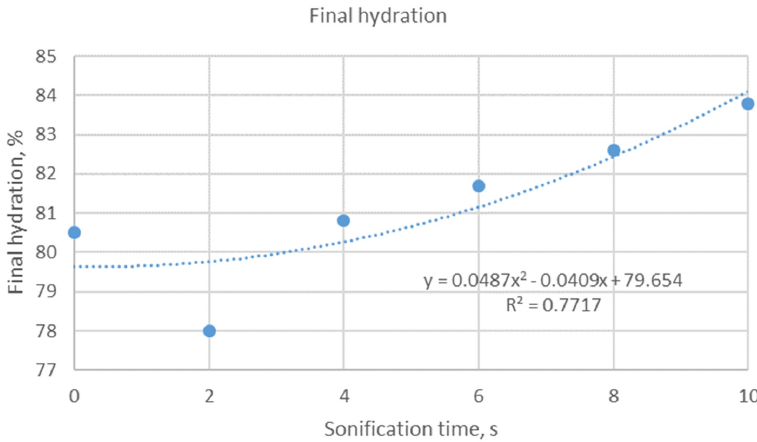
Figure 5. Final hydration of sewage sludge conditioned with sonicated polyelectrolyte.